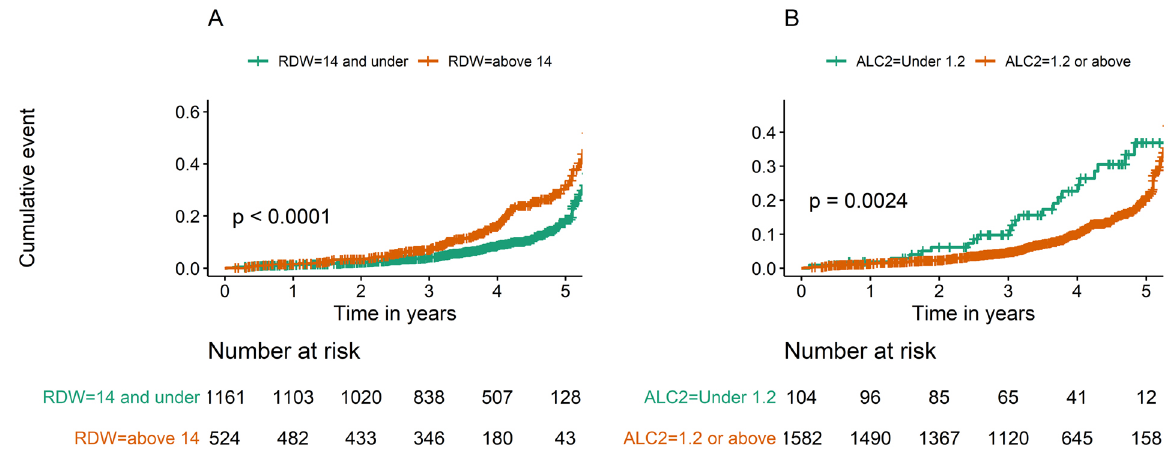
Figure 2. Mortality over 5 years of follow up is higher in patients with high RDW (>14%) and low ALC (<1.2) at time of TE . Mortality risk over 5 years follow up is shown for patients with low (RDW<14) vs high (RDW>14) ( A ) and low (ALC<1.2 10 9 /L) vs high (ALC >1.2 10 9 /L) ( B ). Log Rank Test P values shown.